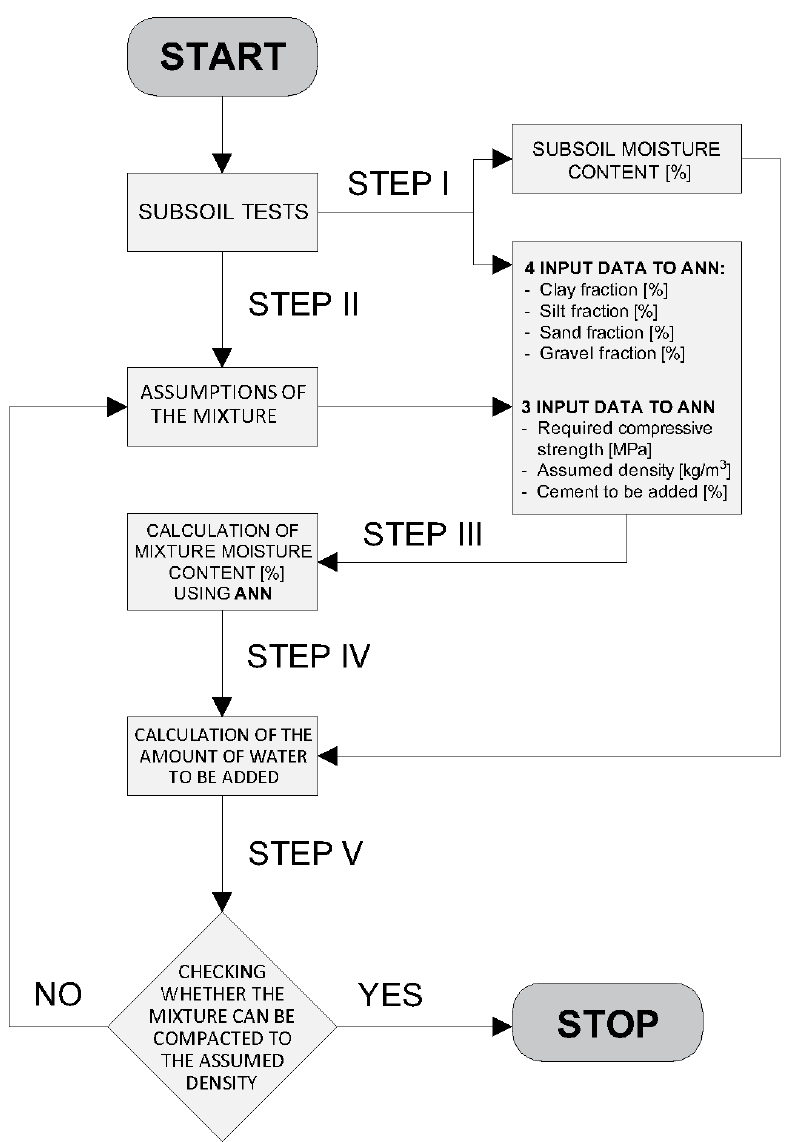
Figure 8. The algorithm for determining the composition of the soil mixture based on field tests.